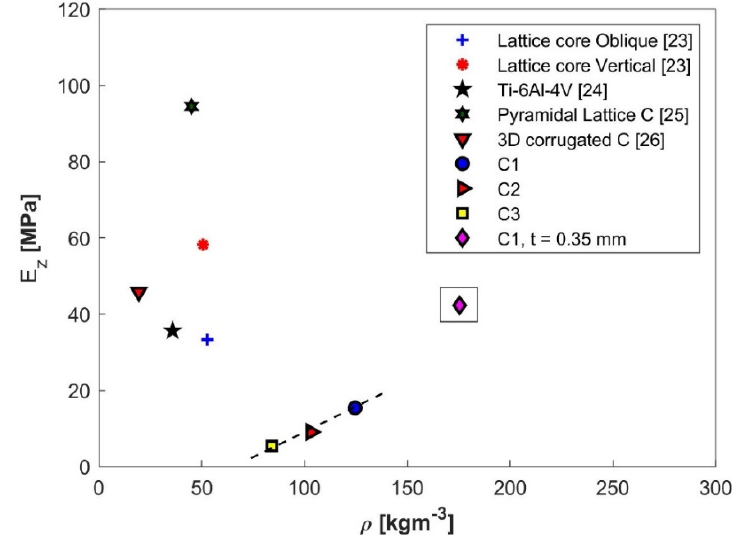
Figure 11. Out-of-plane stiffness as function of core density for several types of cellular structures.